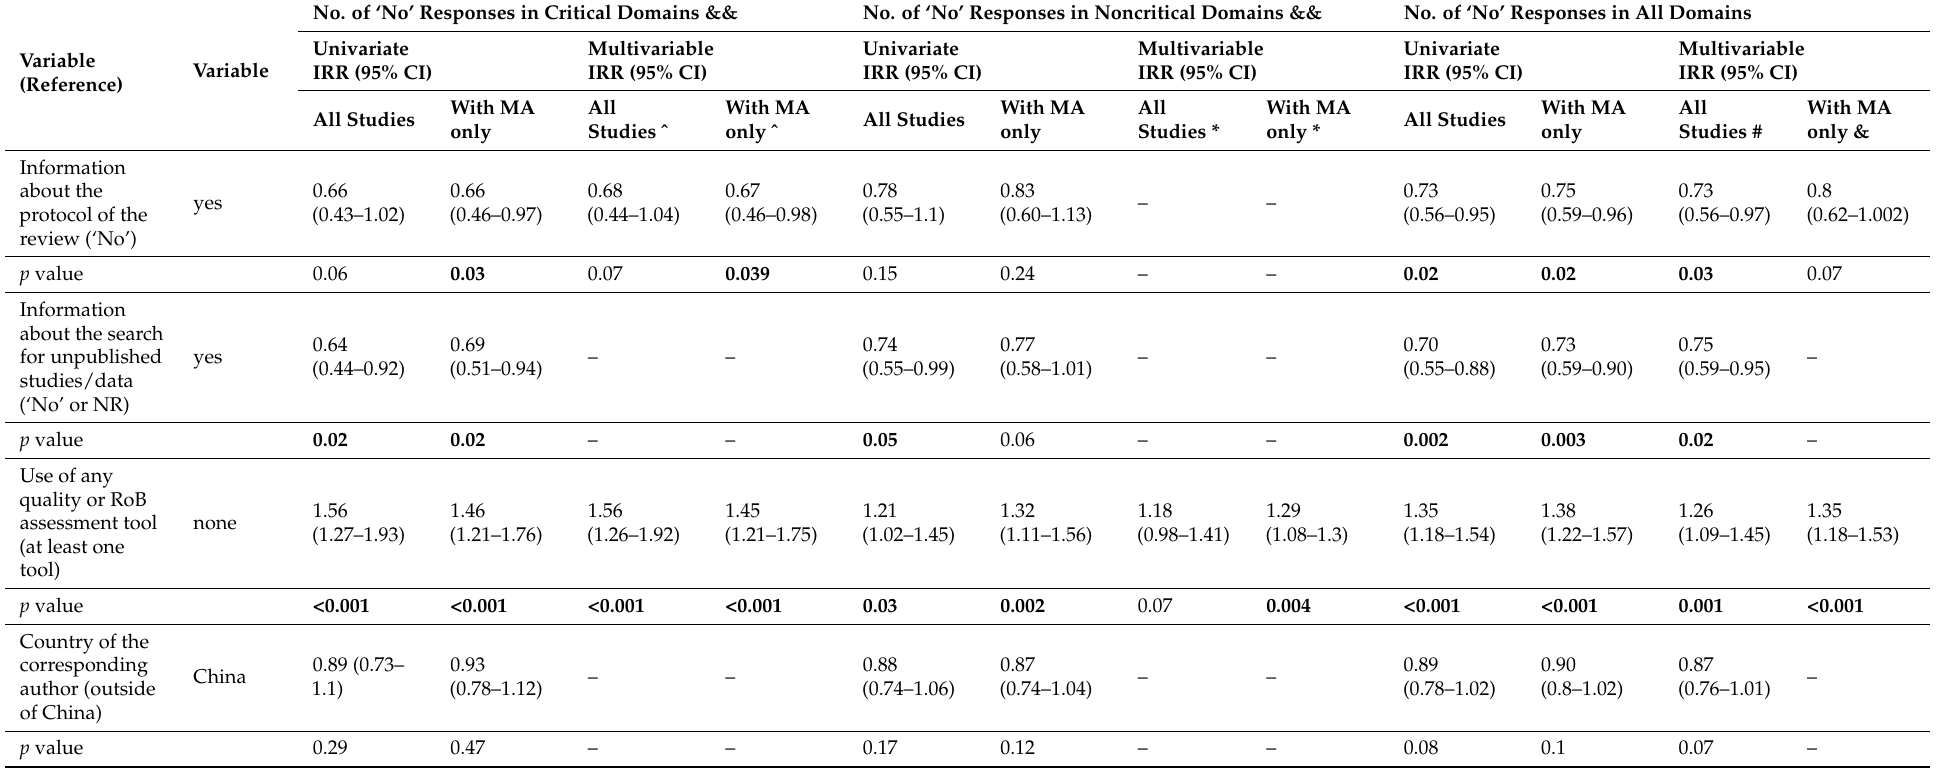
Table 1. Predictors of the number of ‘No’ answers in AMSTAR-2 (Poisson regression